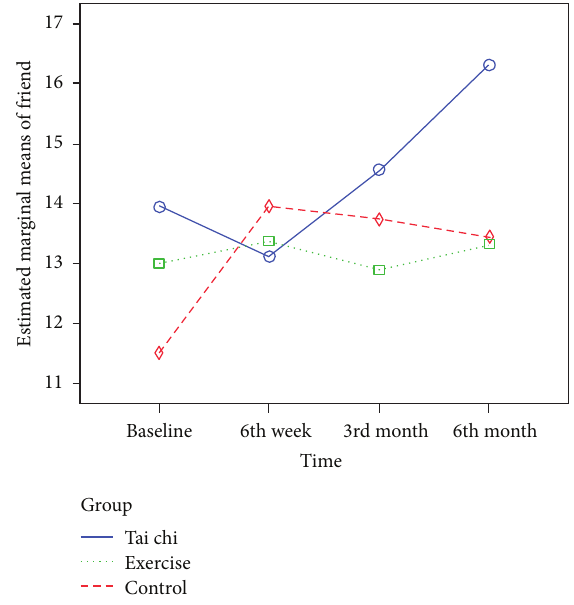
Figure4:Meanscoresofperceivedsocialsupportfromfriendsfrom baseline to 6th